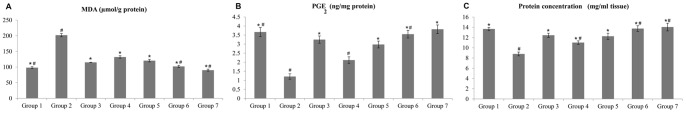
Effects of the complex on malondialdehyde (MDA), prostaglandin E2 (PGE2) and protein concentration (A, B and C).Groups 1 to 3 represent the negative control group, the ulcer control group and the reference control group (omeprazole, 20 mg/kg), respectively. The experimental groups received 10, 20, 40 and 80 mg/kg of the complex are presented as groups 4–7, respectively. All values are expressed as mean ± standard error mean. Mean difference is significant at the p<0.05 level (one-way between groups ANOVA with post-hoc analysis). * significant when compared with the group 2. # significant when compared with the group 3.